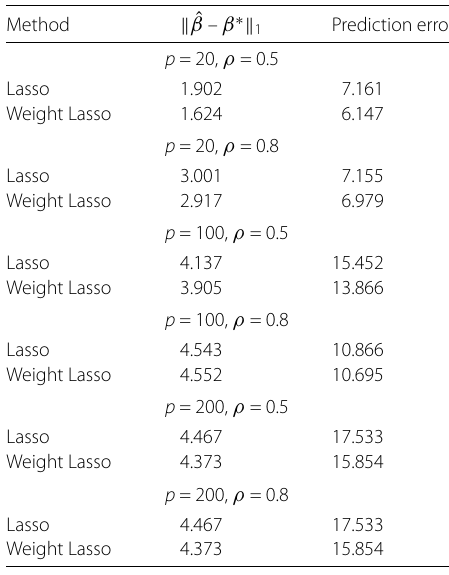
Table 1 Means of (cid:4) 1 error and prediction error